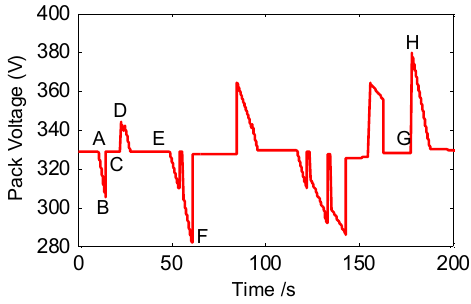
Figure 1. Total voltage curve of the battery pack.